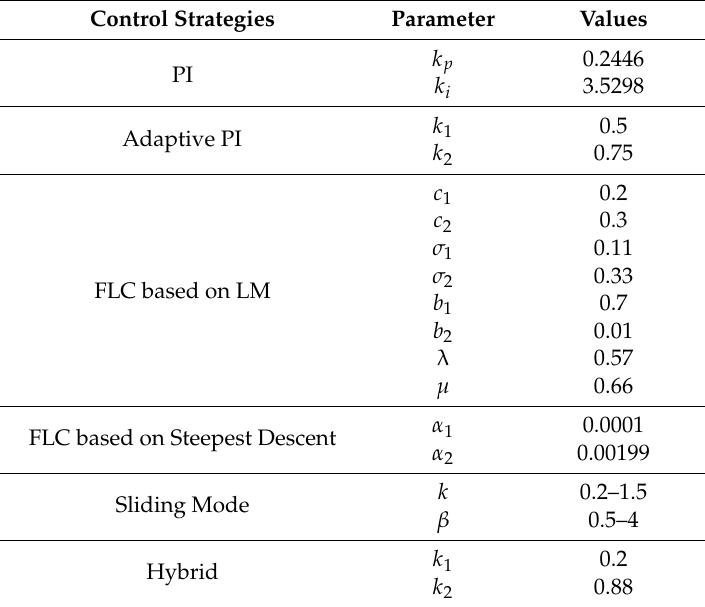
Table A2. Control schemes’